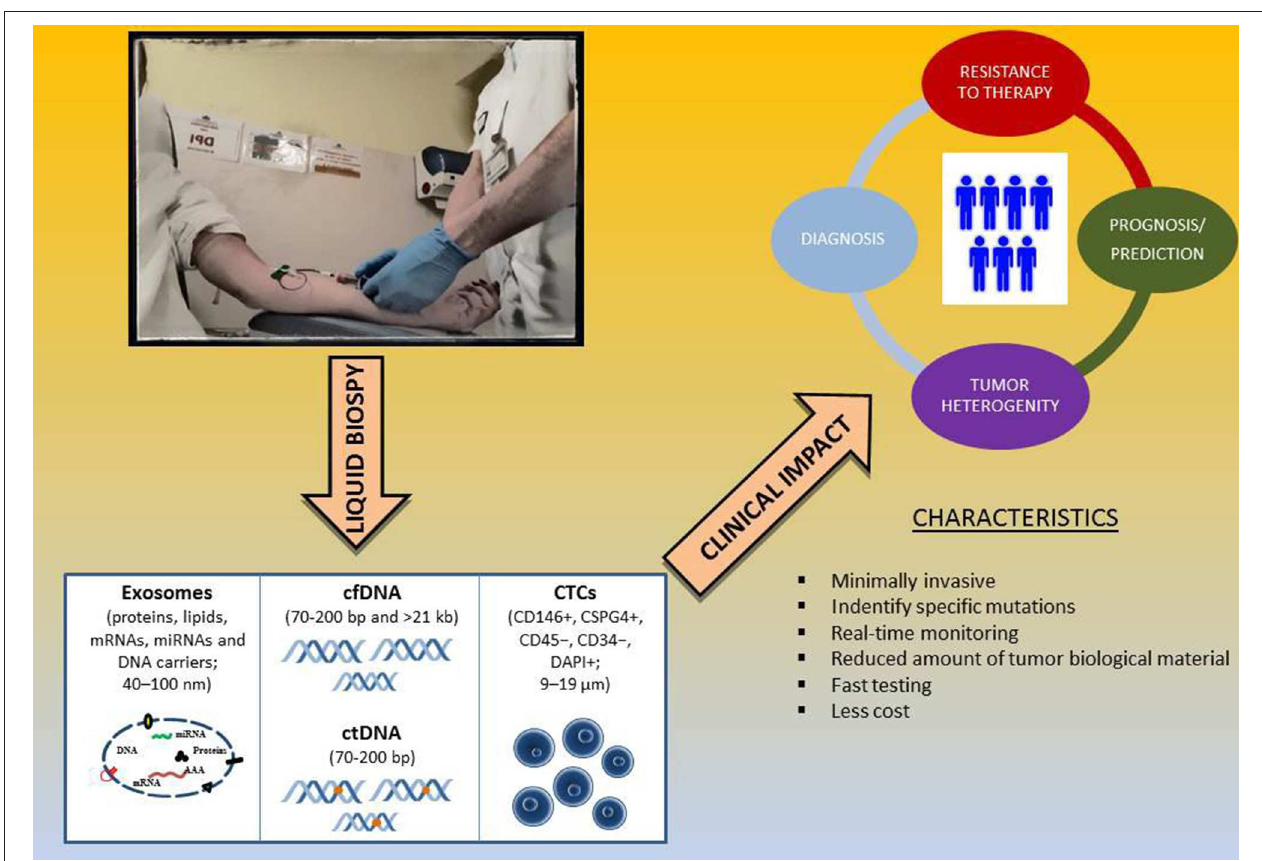
FIGURE 2 | Liquid biopsy as surrogate biomarker in melanoma. Abbreviations: cfDNA, cell free DNA; ctDNA, circulating tumor DNA; CTCs, circulating tumor